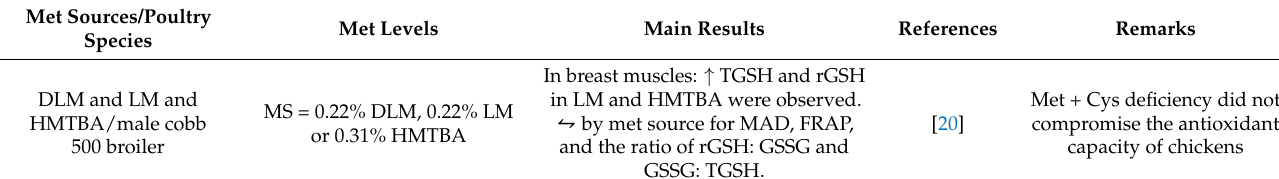
Table 3. Met sources influence poultry oxidative stress and antioxidant status.